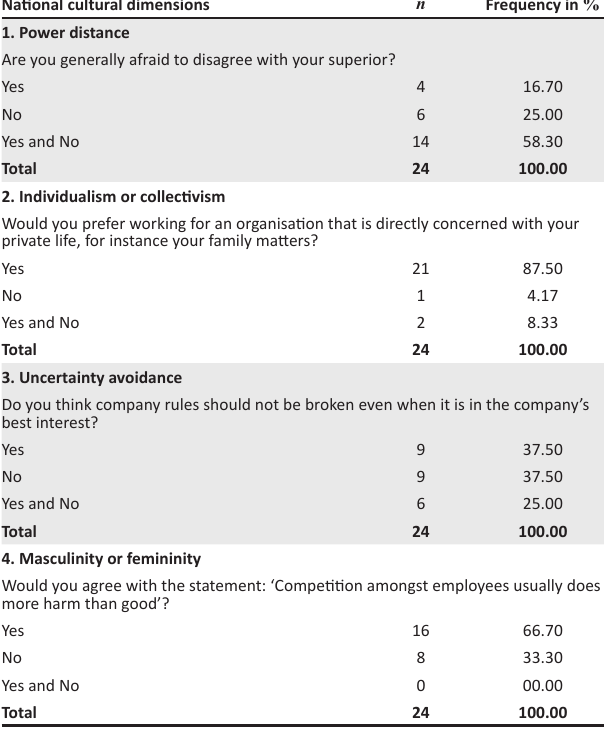
TABLE 6: Effect of cultural orientations on the motivation of employees of MNCs in Kenya. National cultural dimensions n Frequency in %